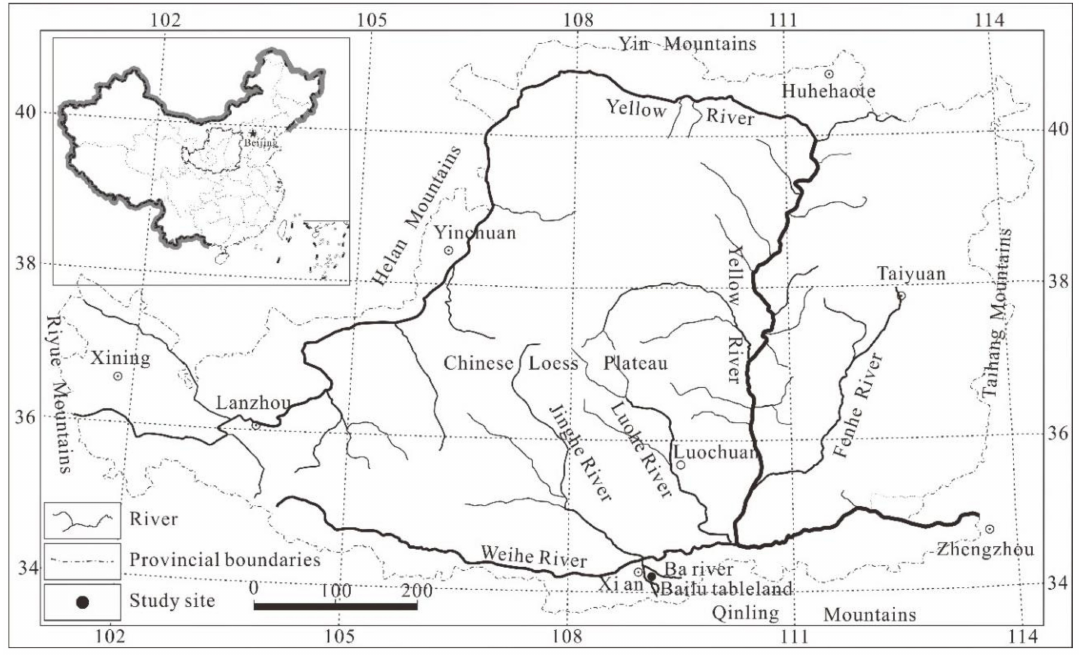
Figure 1. Location of experimental and sampling